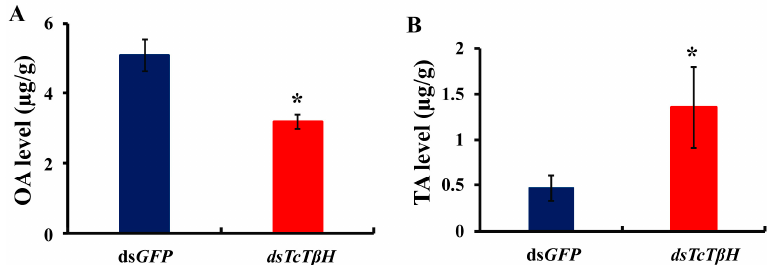
Figure 6. The level of octopamine (OA) and tyramine (TA) by HPLC. ( A ) The detection of the OA level by HPLC after RNAi; ( B ) The detection of the TA level by HPLC after RNAi. The asterisk represents a significant difference by an independent t test ( n = 3, *, p < 0.05).